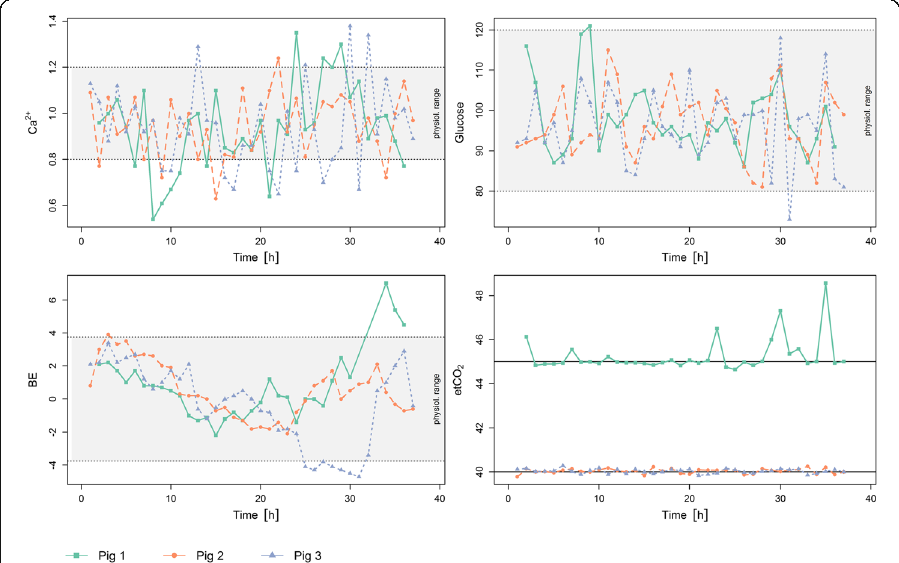
Fig. 2 Results for the fuzzy-controlled parameters and set targets (horizontal lines) for the individual pigs: calcium levels (top left), glucose levels (top right), BE level (bottom left), and etCO 2 (bottom